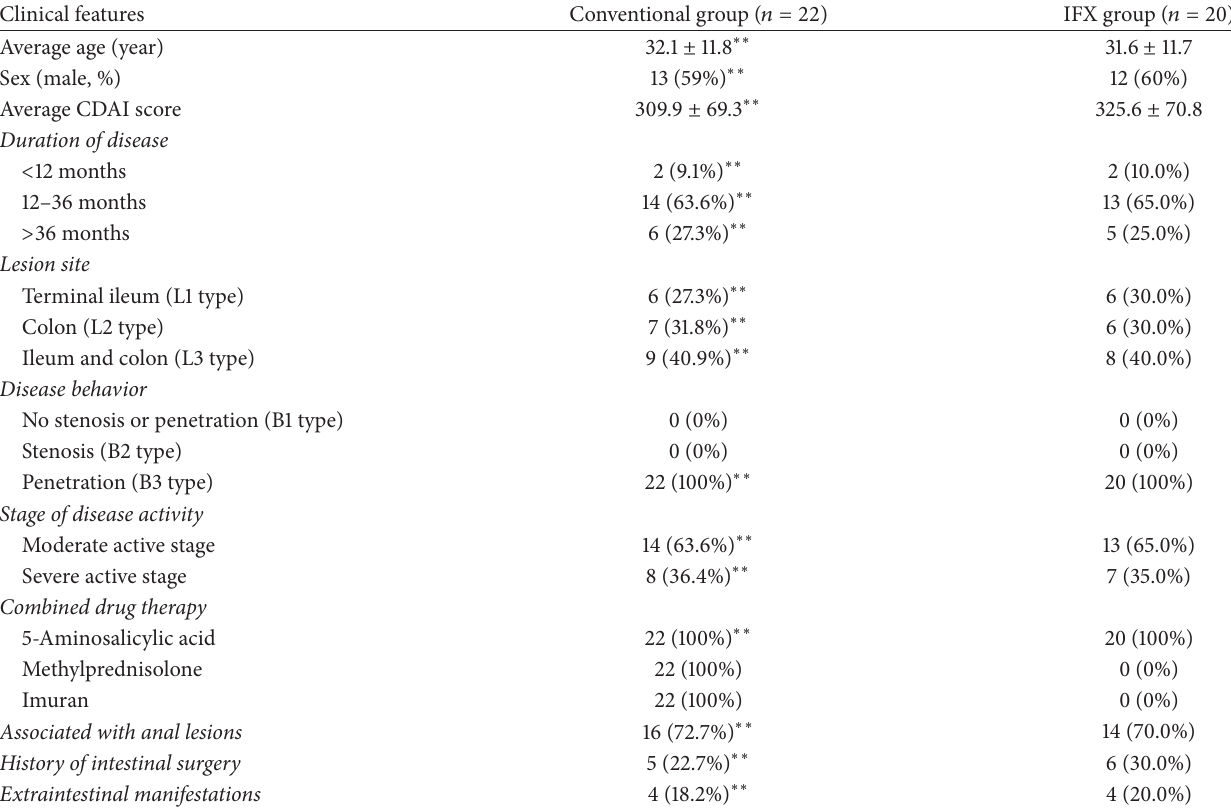
Table 1: The clinical characteristics of 42 patients with CD.